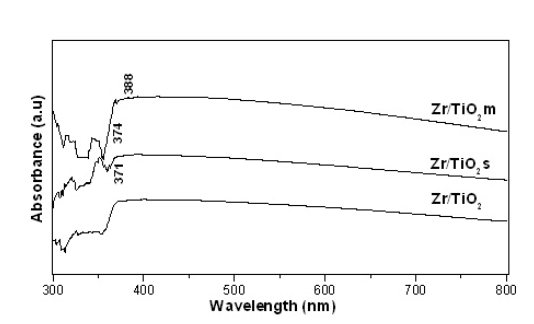
Figure 2. UV-VIS DRS of prepared